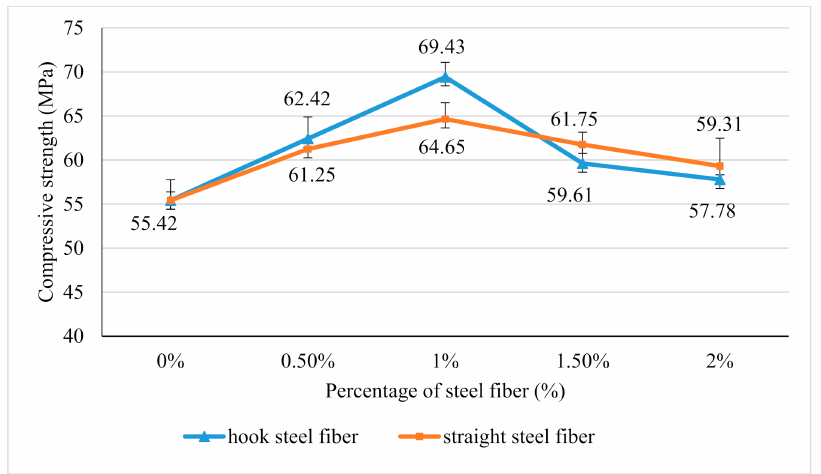
Figure 6. Compressive strength of hook steel fiber and straight steel fiber reinforced geopolymer concrete versus steel fibers addition.